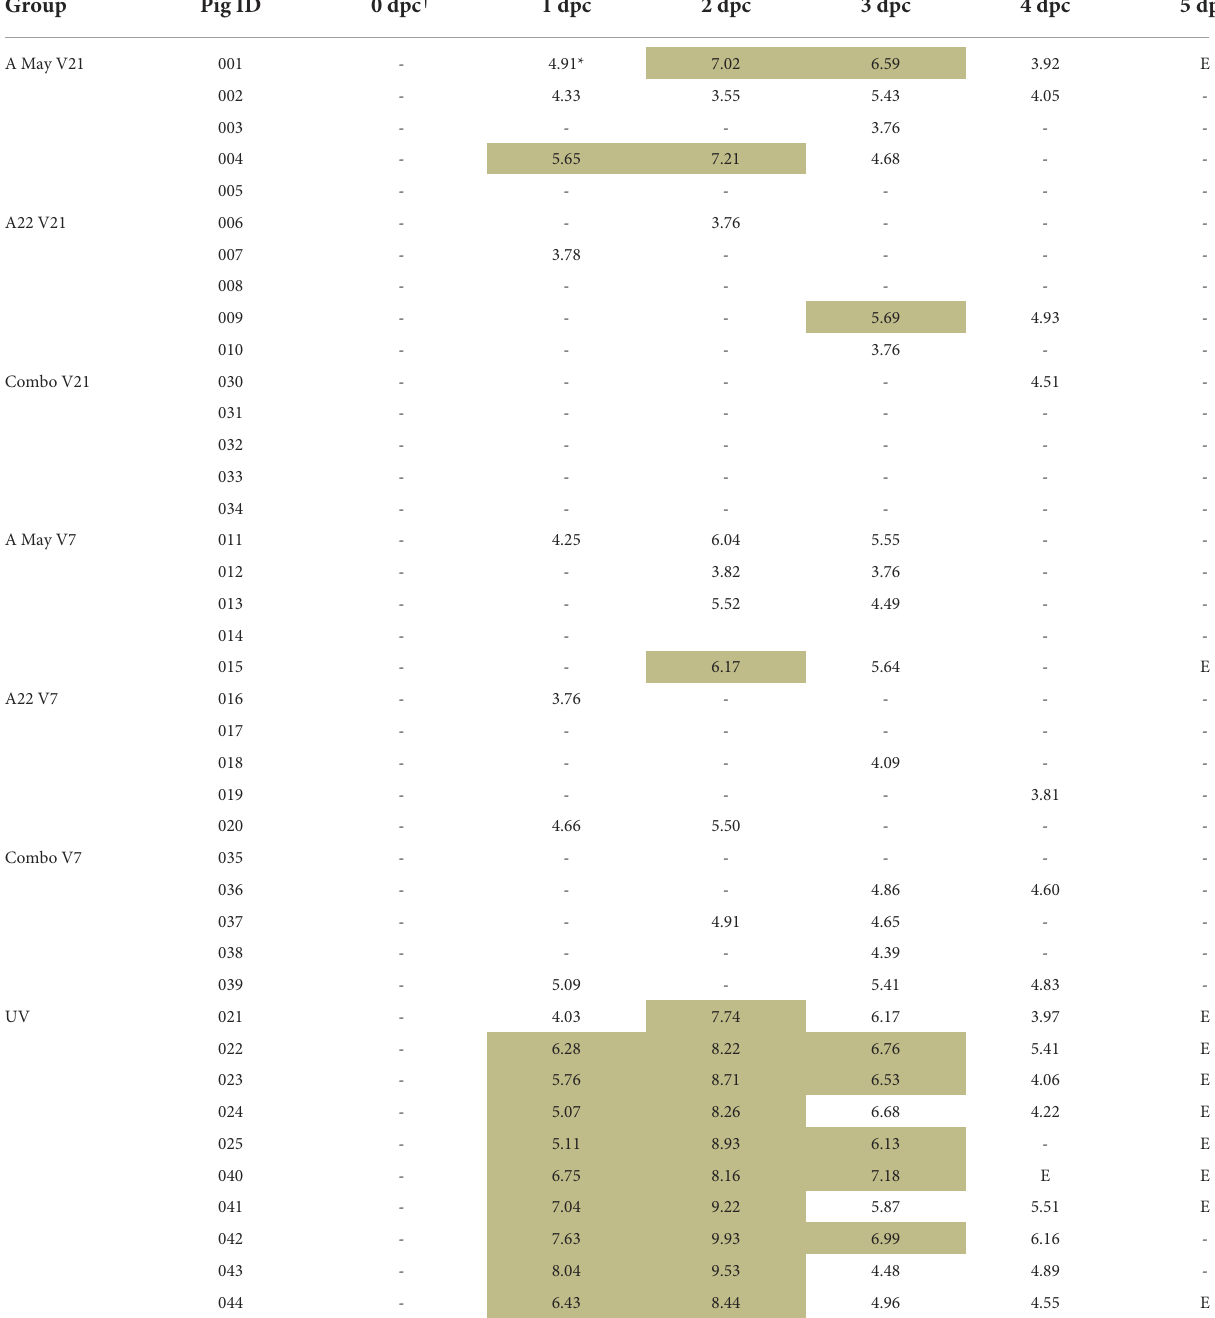
TABLE 2 Viral RNA concentration measured as log 10 copy numbers/ml by a reverse transcription and quantitative PCR (RT-qPCR) in sera from animals challenged with A/TAI/15/2013 virus.